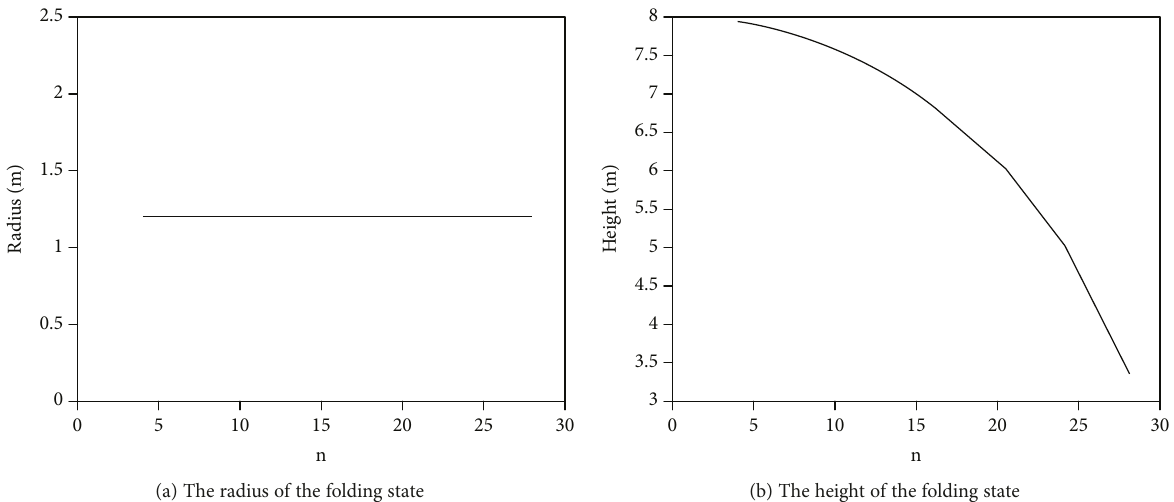
Figure 12: Change of the radius and the height of folding state with n